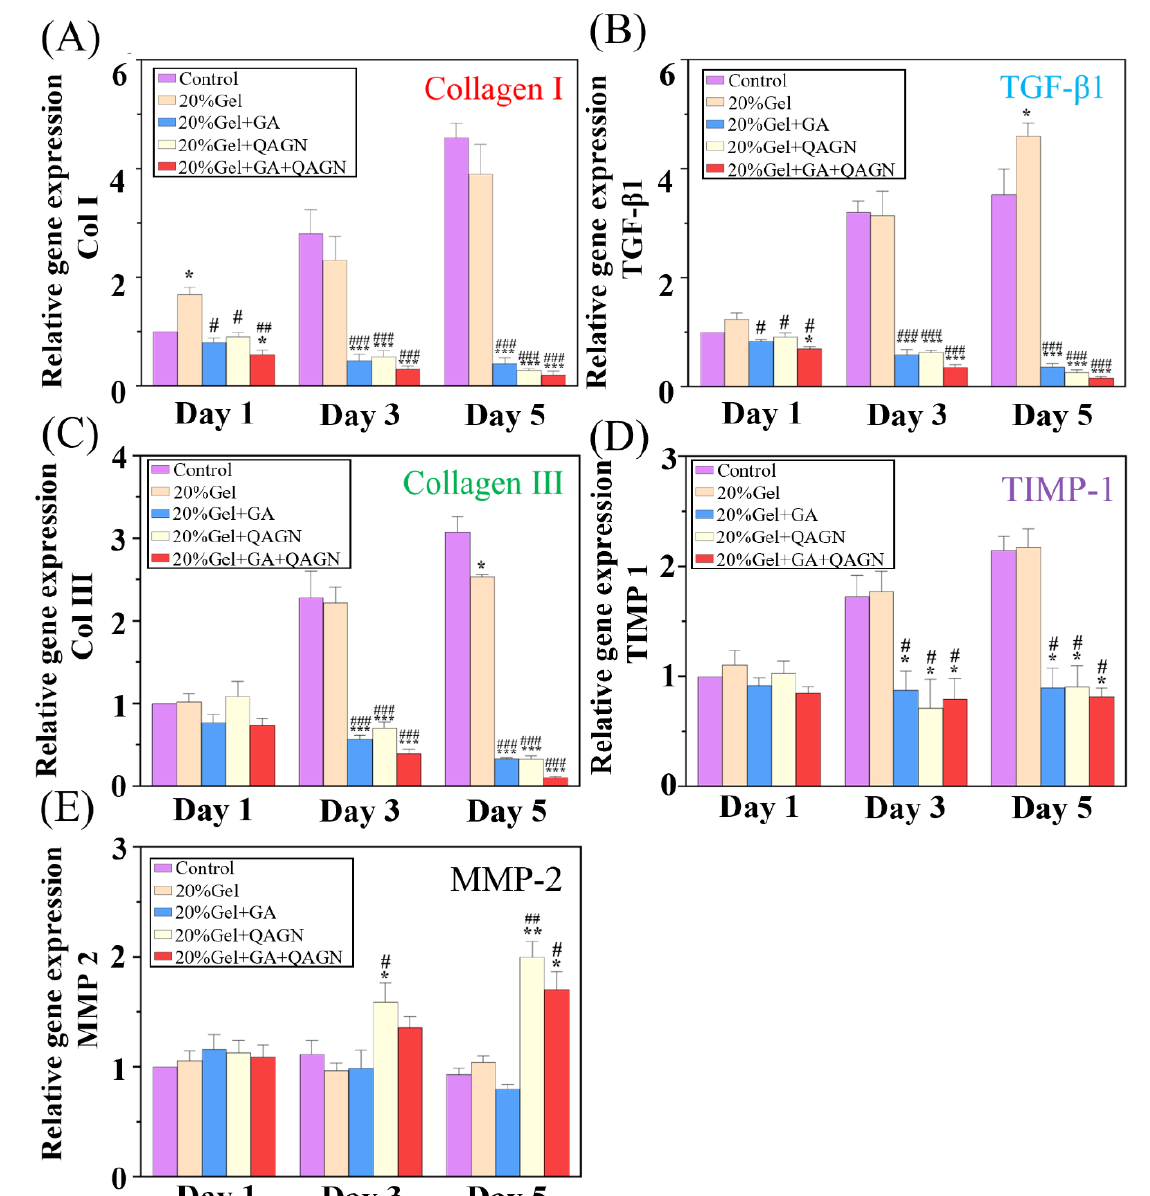
Figure 9. Relative expression levels of keloid scar and genes for extracellular-matrix-degrading metalloproteinases, including ( A ) Col I, ( B ) TGF- β 1, ( C ) Col III, ( D ) TIMP-1, and ( E ) MMP-2 analysed to detect the influence of QAGN and GA on fibroblasts. Data are represented mean ± SD, * compared with the control group. * p < 0.05, ** p < 0.01, *** p < 0.001, and # compared with the gelatin group # p < 0.05, ## p < 0.01, ### p < 0.001.